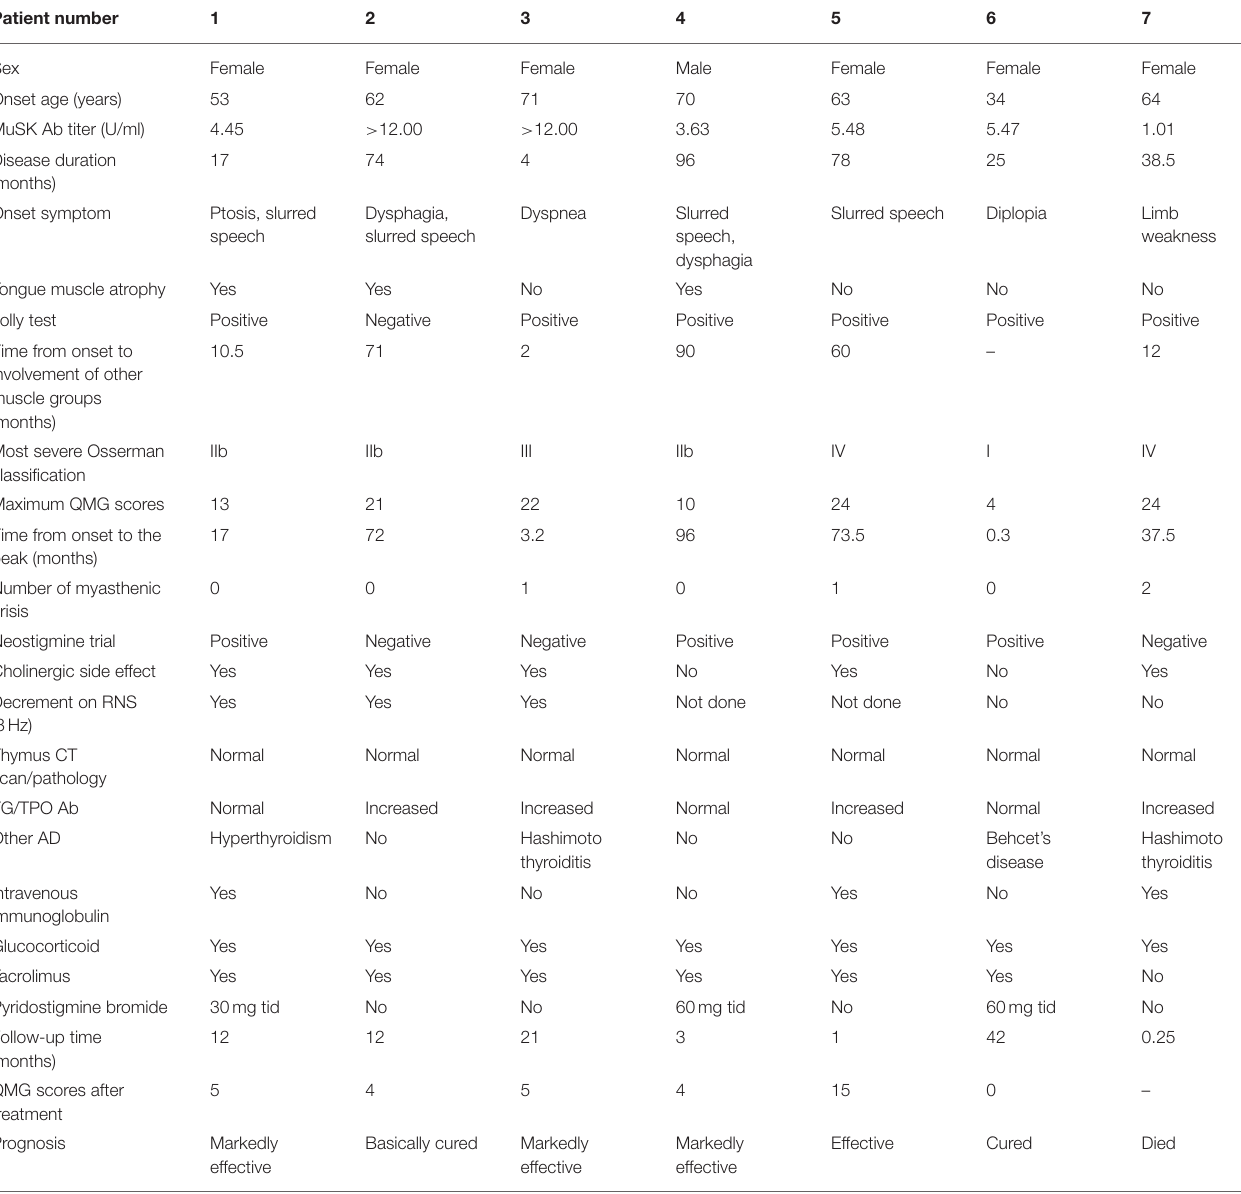
TABLE 1A | Detailed clinical data of the 14 MuSK-MG